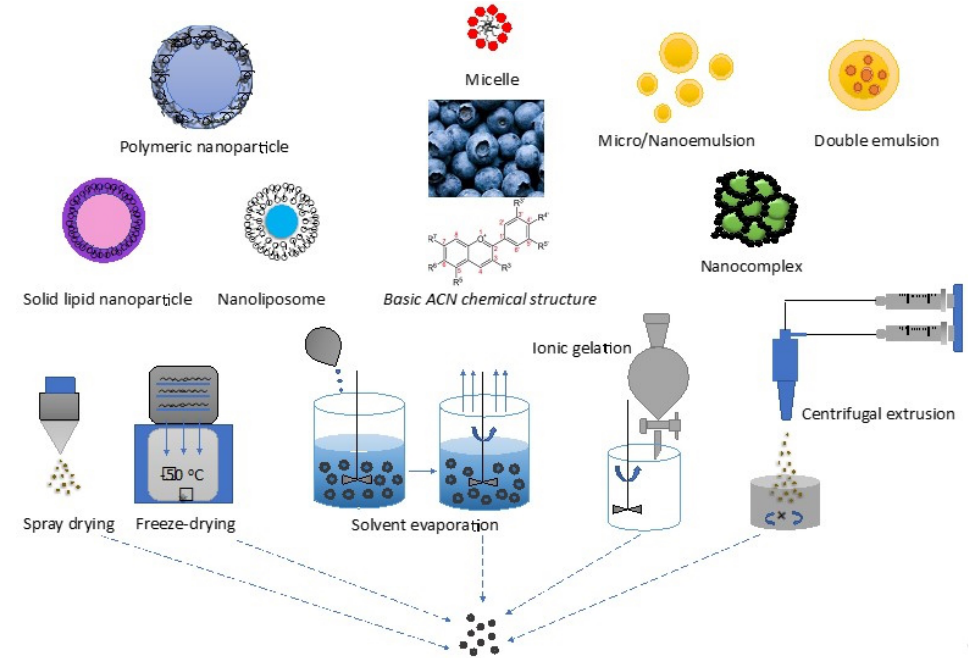
Figure 2. Microencapsulation/nanoencapsulation of BB ACNs to protect and improve their bioavail- ability. (Top) Different ACN delivery systems/vehicles. (Bottom) Typical techniques commonly used in